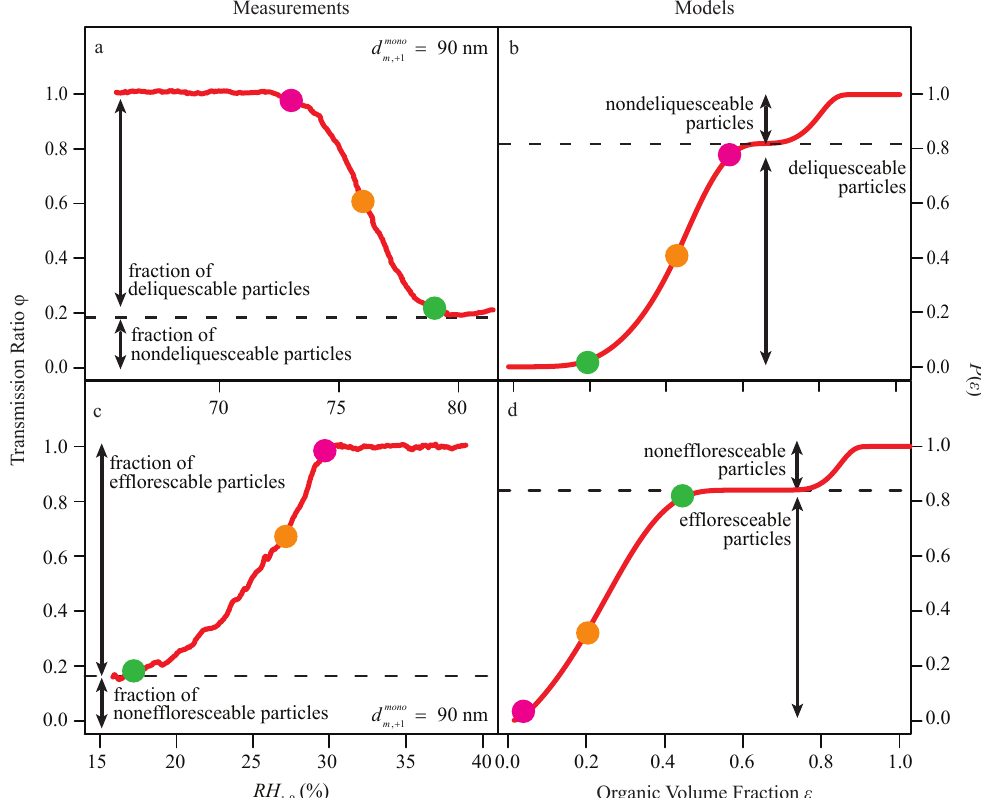
Fig. 2. Examples of data sets and associated analysis for transmission ratio experiments. (a) Transmission ratio φ of the particle population as RH 1 ,β is scanned upward. These experiments are designed to identify deliquescence transitions. The ratio drops from unity as the particles deliquesce. (b) Cumulative distribution function of organic volume fraction ε for this particle population. The colored circles of (a) and (b) show points of correspondence between the φ (RH) and P ( ε ) curves (i.e., the green circle shows that the highest DRH value matches with the lowest value of ε ). The corresponding points of each curve are the basis of the DRH( ε ) curves shown in Fig. 4. Panels (c) and (d) are as described for (a) and (b) with the difference that RH 1 ,β is scanned downward in experiments designed to identify efflorescence transitions. The corresponding data points of (c) and (d) are the basis of the ERH( ε ) curves shown in Fig.